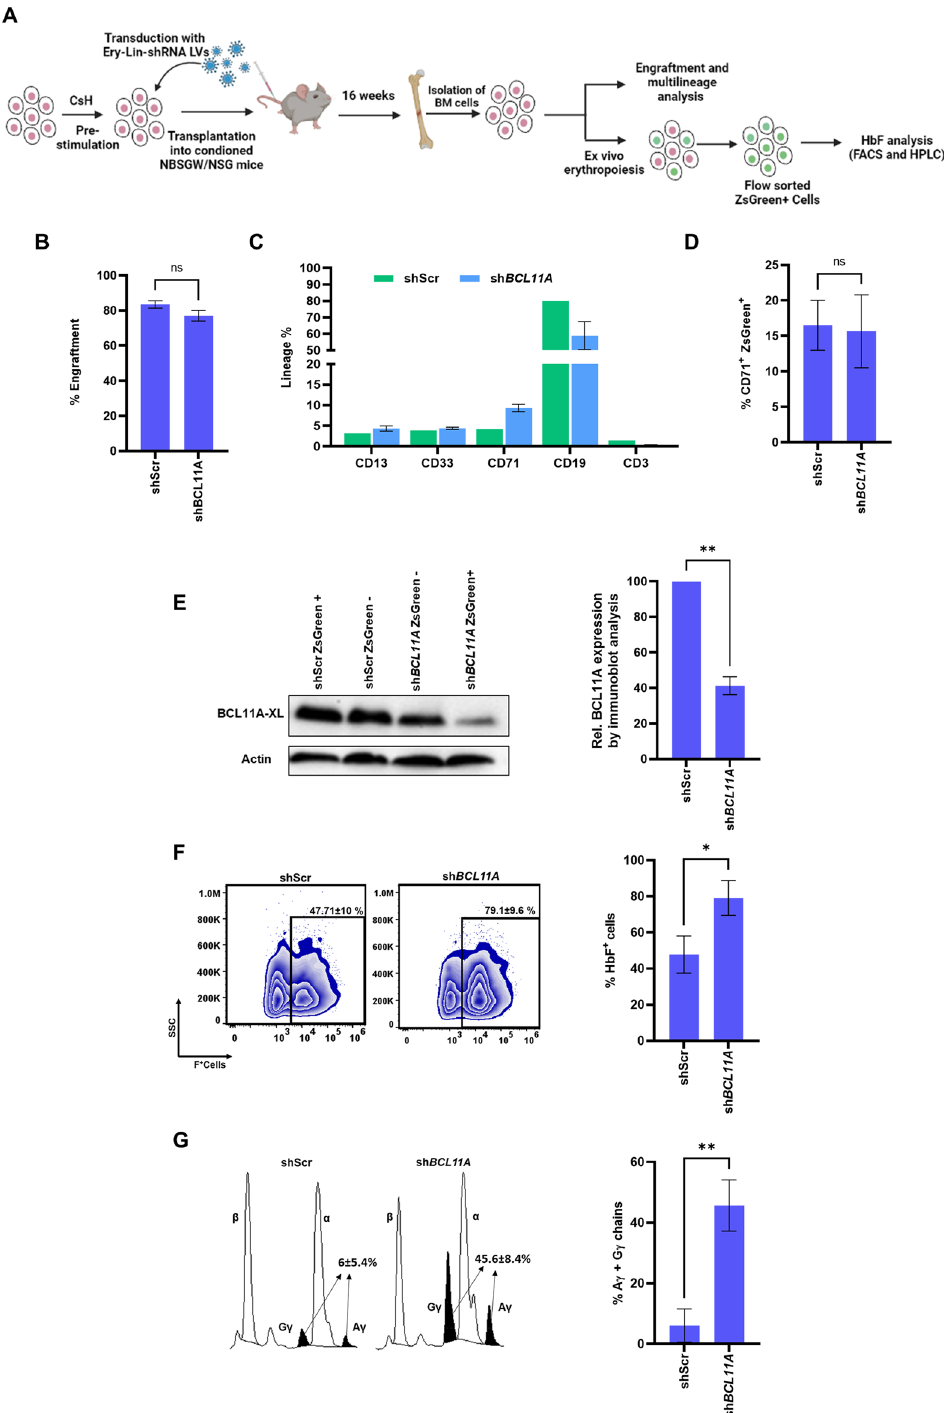
Figure 4. Analysis of the engrafted H23BW-Ery-Lin-sh BCL11A LV transduced HSPCs in NBSGW mice. ( A ) Schematic representation of the mouse transplantation experiment. CsH: cyclosporin H. ( B ) The percentage engraftment measured in the total BM cells isolated 15 weeks after transplantation. ( C ) Multilineage analysis in the human CD45 positive (hCD45 + ) cells after 15 weeks of transplantation. ( D ) The percentage of CD71 + ZsGreen + cells in the erythroid cells obtained from BM by ex vivo erythropoiesis. ( E ) Representative immunoblots (left) and the densitometric quantitation of BCL11A knockdown (right) in the flow-sorted ZsGreen + erythroid cells (normalized to actin levels). ( F ) Intracellular HbF analysis by flow cytometry to determine the percentages of HbF + cells in the terminally differentiated ZsGreen + erythroid cells (left) and the graphical representation of the data (right). ( G ) HPLC analysis of the percentages of Gγ+Aγ chains in the terminally differentiated ZsGreen + erythroid cells after differentiation (left) and the graphical representation of the data (right). All data are compared to shScr. All data are mean ± SD (n = 3). ns, not significant, * p < 0.05 and ** p <